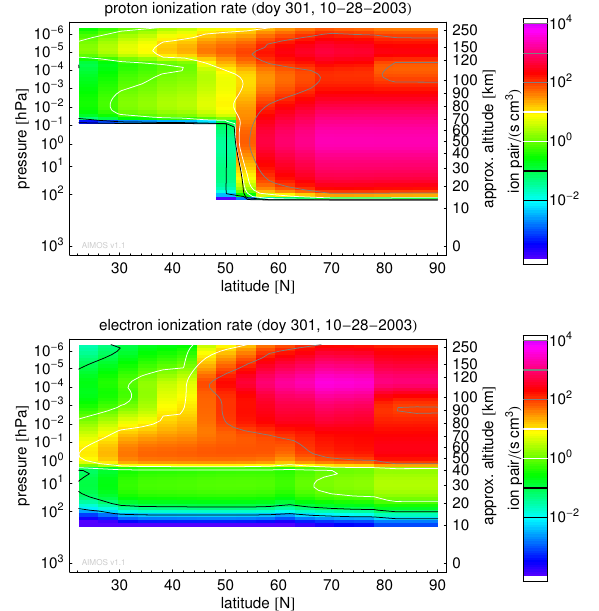
Fig. 4. Altitude-latitude sections of AIMOS ion pair production rates for protons (top) and electrons (bottom) on 28 October 2003.